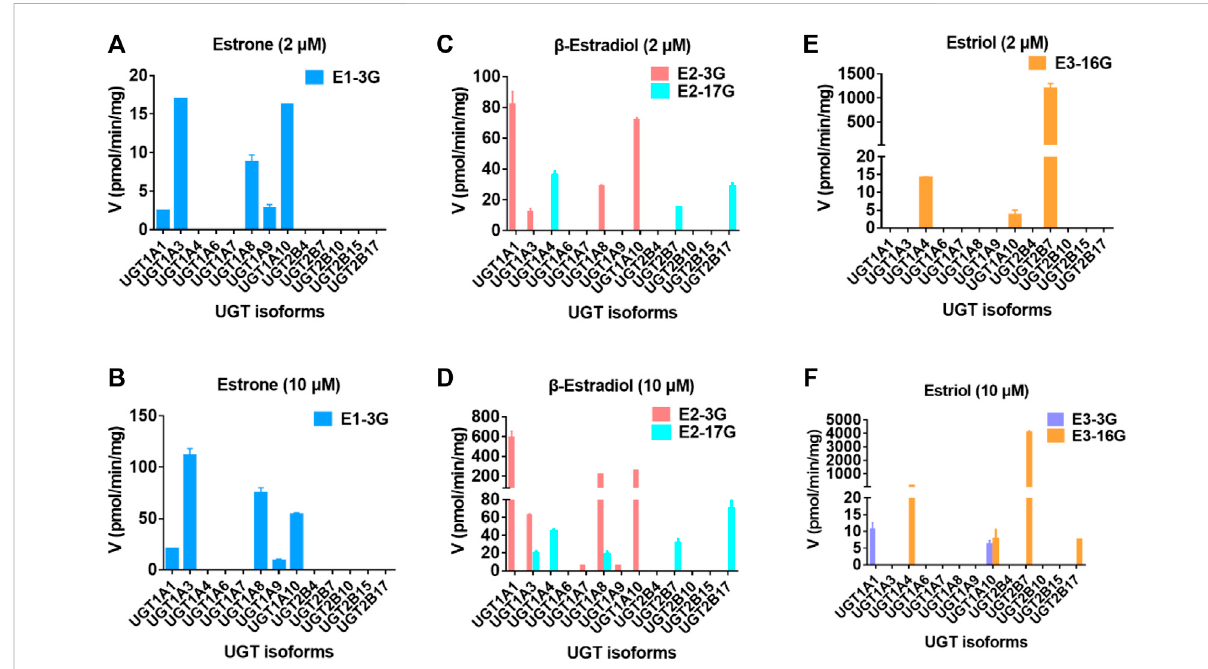
FIGURE 7 Comparisons of glucuronidation rates of estrone at 2 μ M (A) and 20 μ M (B) , β -estradiol at 2 μ M (C) and 20 μ M (D) , and estriol at 2 μ M (E) and 20 μ M (F) by thirteen expressed UGT enzymes. All experiments were performed in